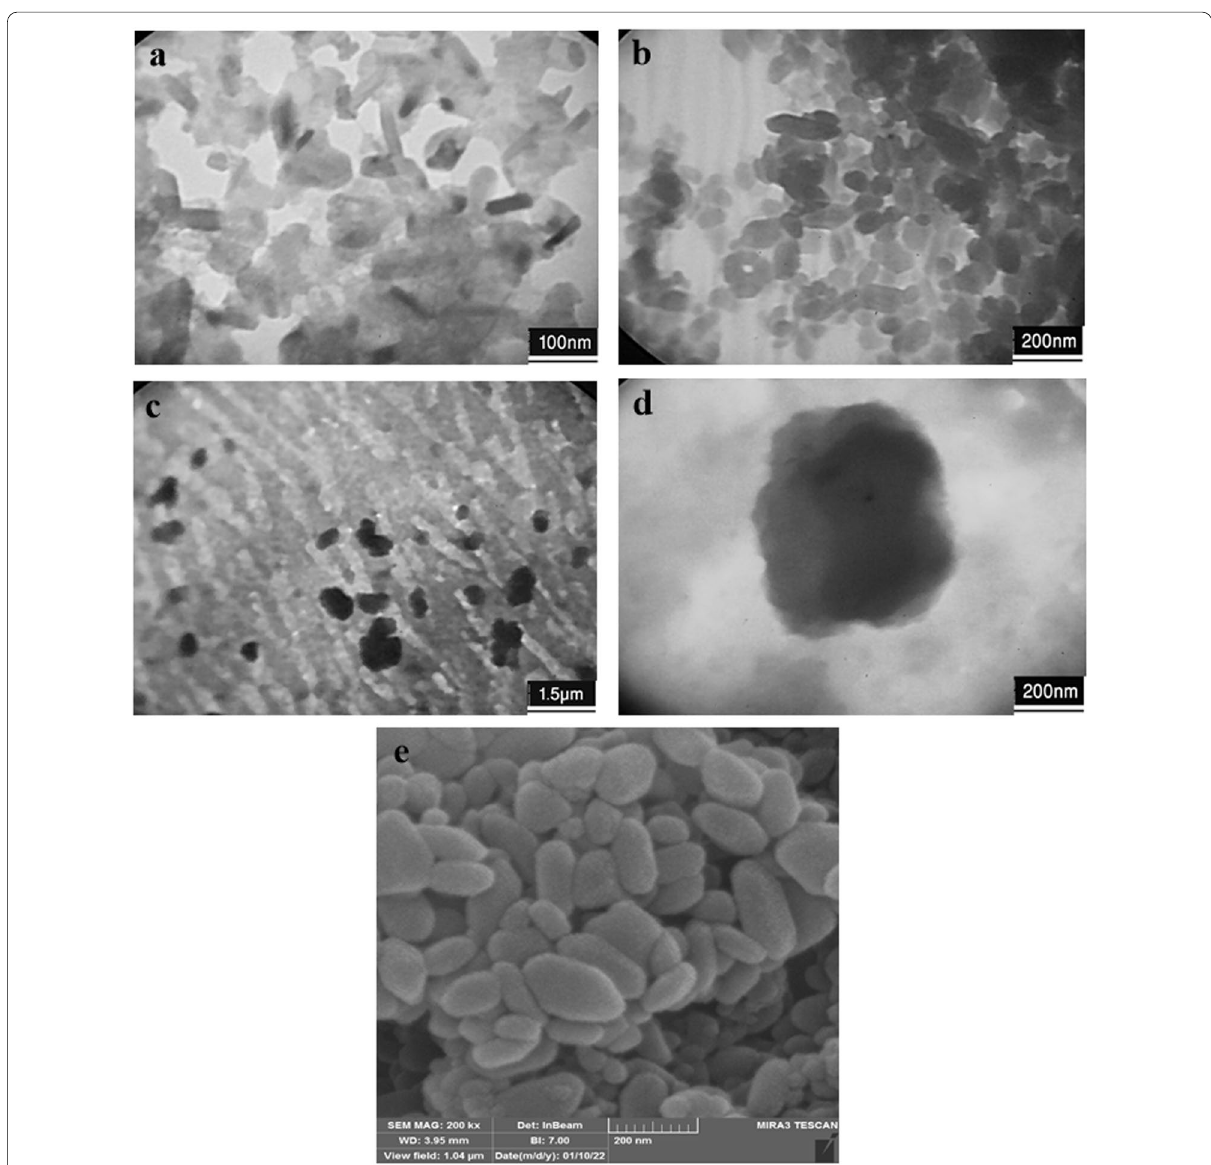
Fig. 3 a TEM image of CuNCs, b TEM image of ZIF-8, c – d TEM image of CuNCs@ZIF-8, e FE-SEM image of